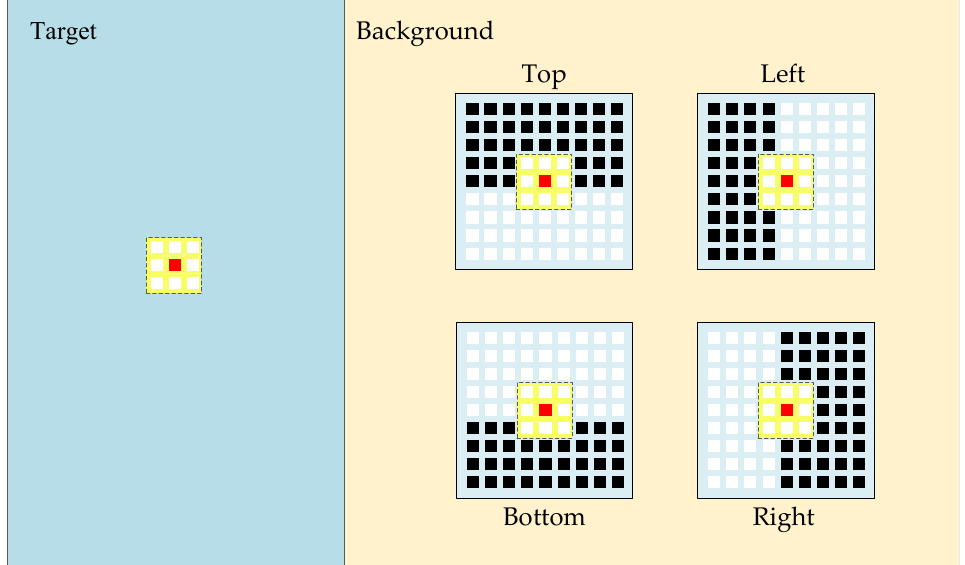
Figure 3. Target and surround background area division diagram. In the process of background division, black squares represent the selected area.